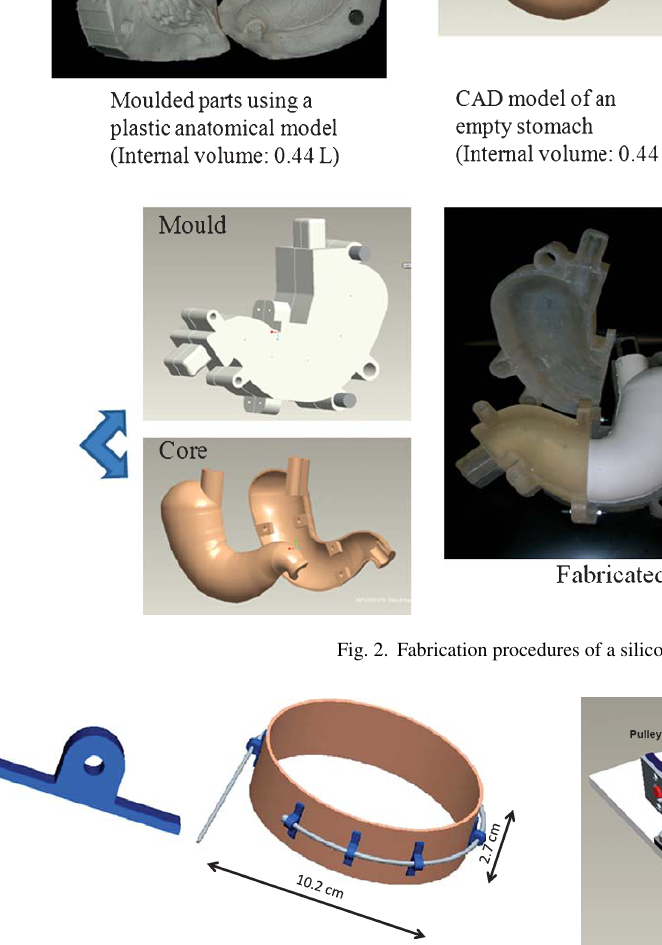
Fig.3. Retainingstructureandexampleofsiliconecylindricalstruc- ture to be contracted with the designed cables actuation system.